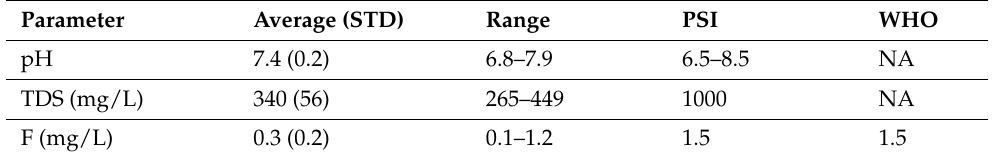
Table 3. Physicochemical parameters of the groundwater from 29 wells in West Bank, Palestine [27].